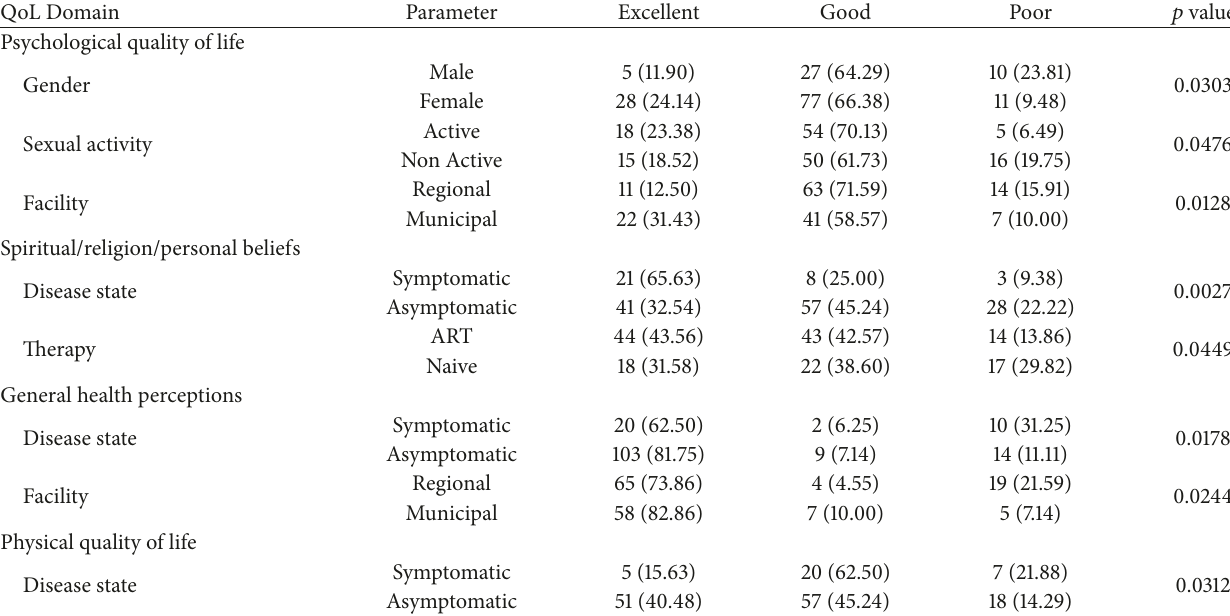
Table 5: Associated variable with the component of quality of life of people living with HIV/AIDS in the Ho